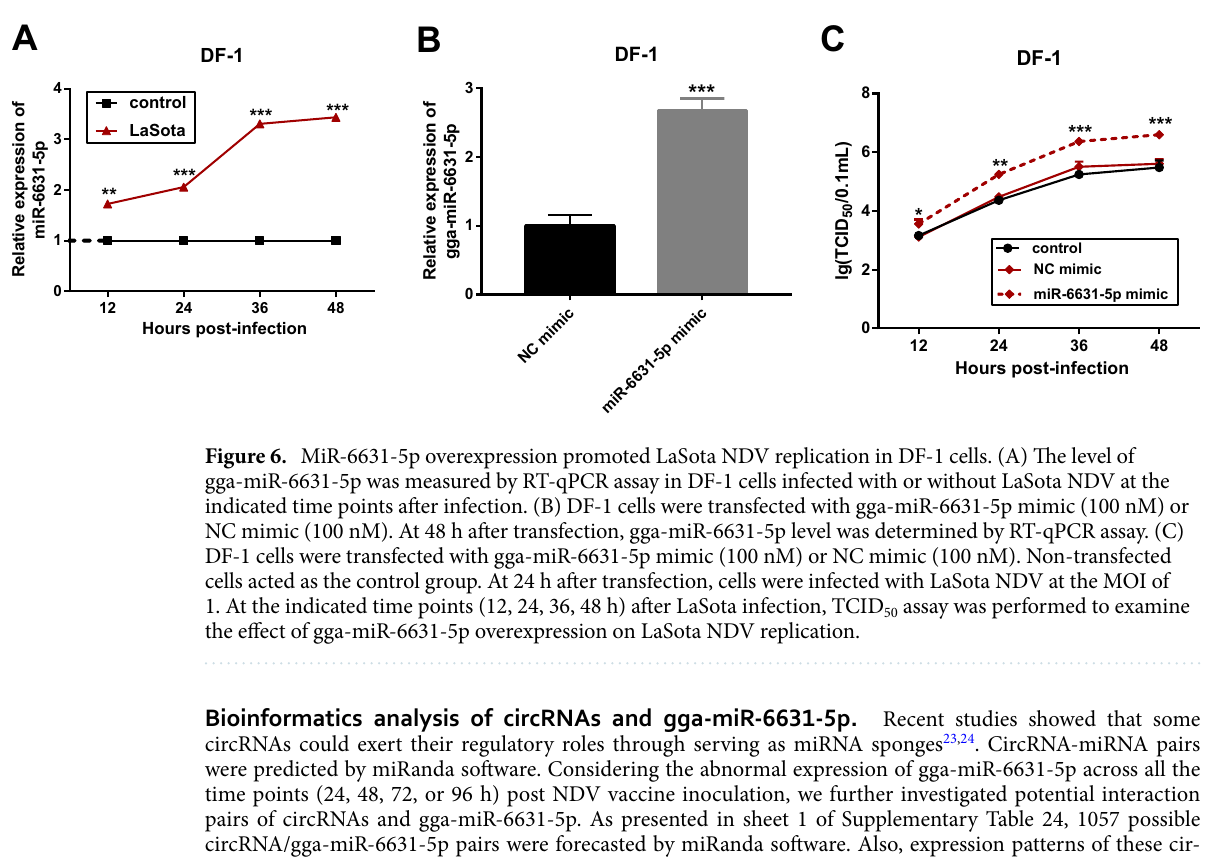
plementary Table 21. Expression data of E2F1, INSIG1, HSPBP1, MAPK10, MASP2, SERPING1 and PSMD11 were presented in Supplementary Table 26.